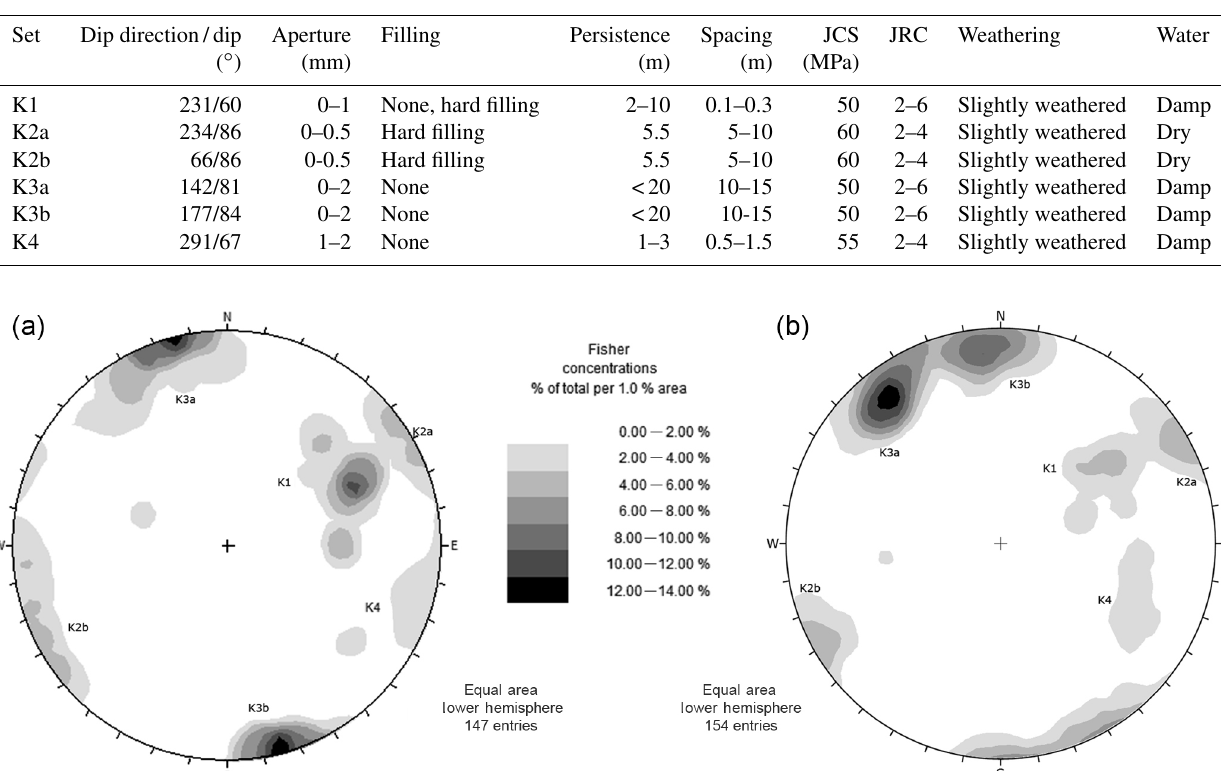
Figure 7. Stereonet plot of poles (Schmidt, equal area, lower hemisphere) of the discontinuities manually collected through classical engi- neering geological survey (a) and remotely collected by using photogrammetric data from RPAS surveys (b)